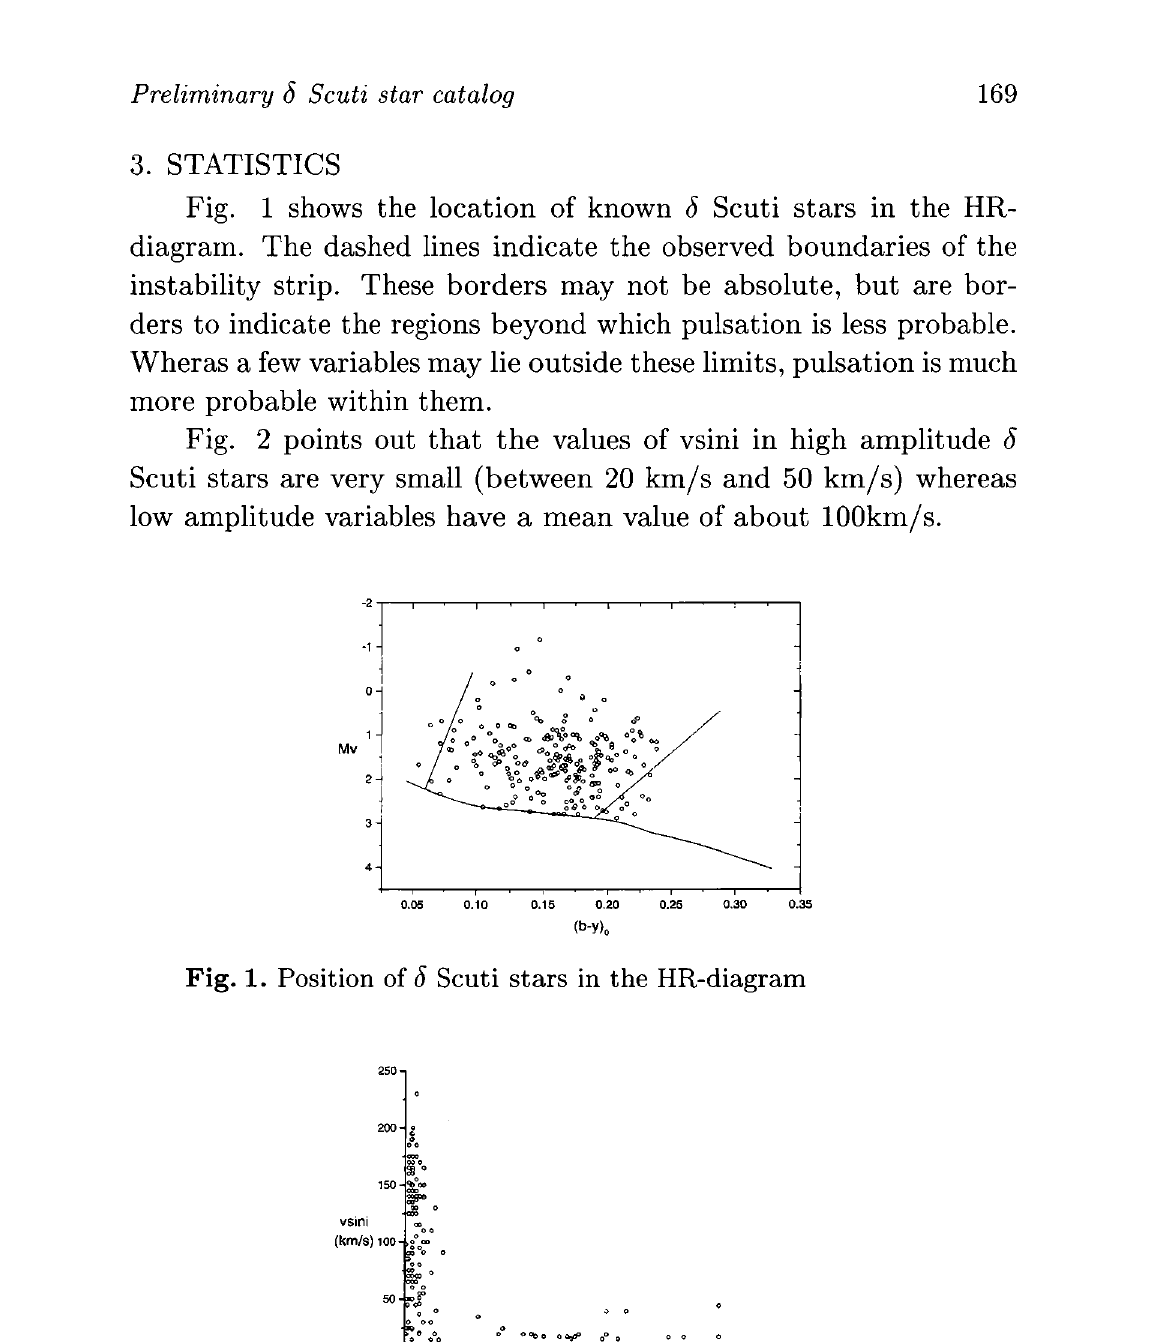
Fig. 1. Position of 5 Scuti stars in the HR-diagram